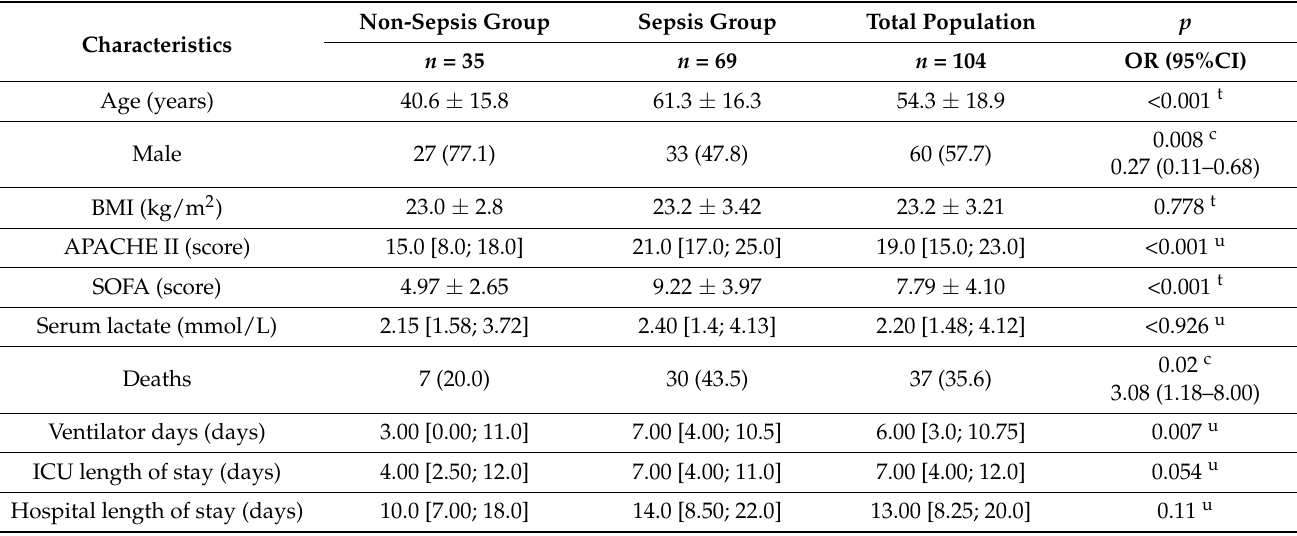
Table 1. General characteristics of 104 study participants.